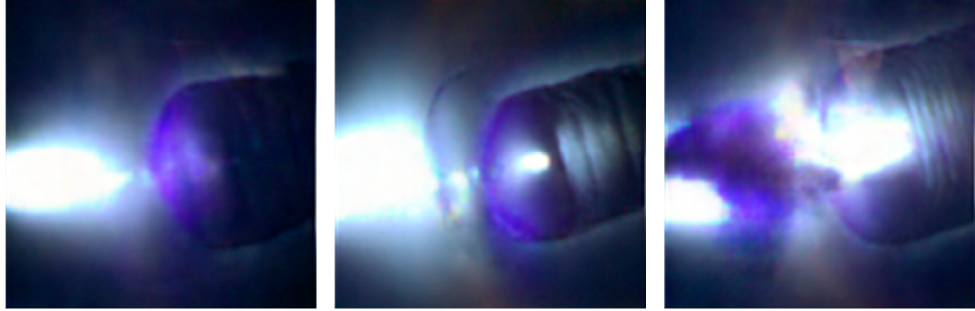
Figure 6. Images generated by the training model.